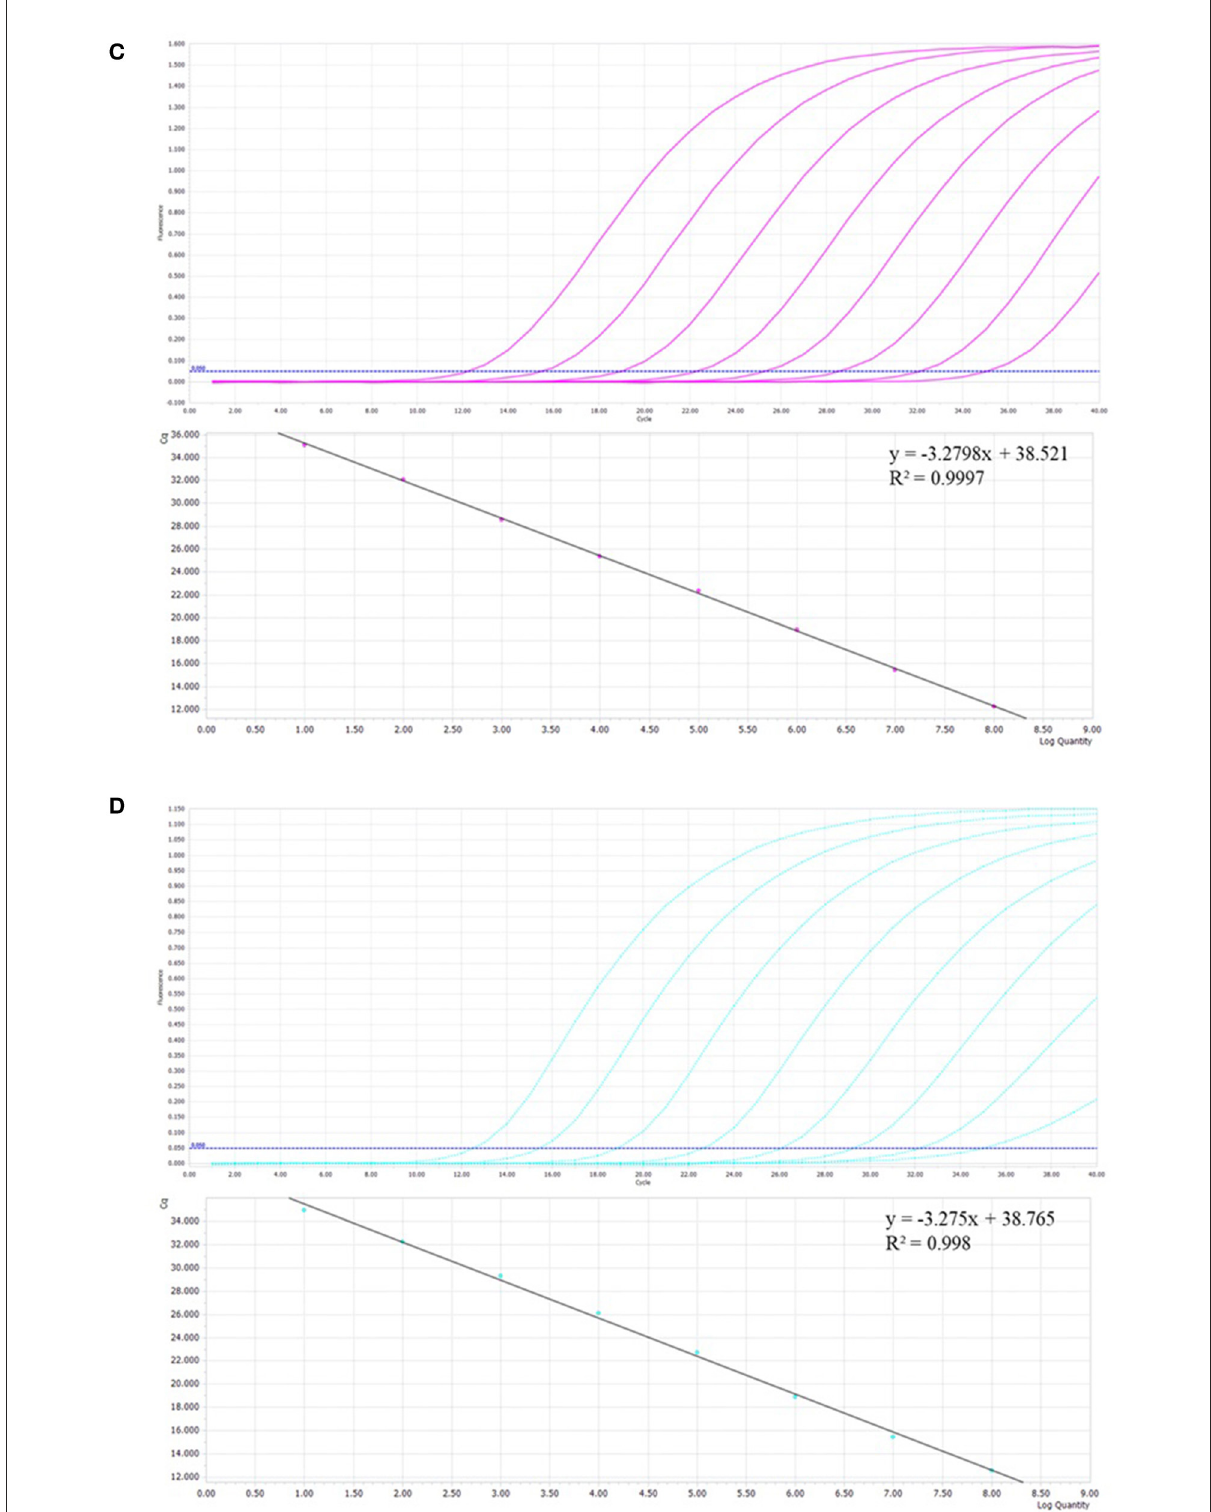
FIGURE1 (A–D) The amplification curves (top, X-axis: Cycle, Y-axis: Fluorescence) and standard curve (bottom, X-axis: Log Quantity, Y-axis: Cq) for the single qPCR assay of individual viruses. (A) Feline parvovirus (FPV) plasmids from 10 8 to 10 1 copies/ µ L. (B) Feline bocavirus 1 (FBoV-1) plasmids from 10 8 to 10 1 copies/ µ L. (C) Feline kobuvirus (FeKoV) plasmids from 10 8 to 10 1 copies/ µ L. (D) Feline astrovirus (FeAstV) plasmids from 10 8 to 10 1 copies/ µ